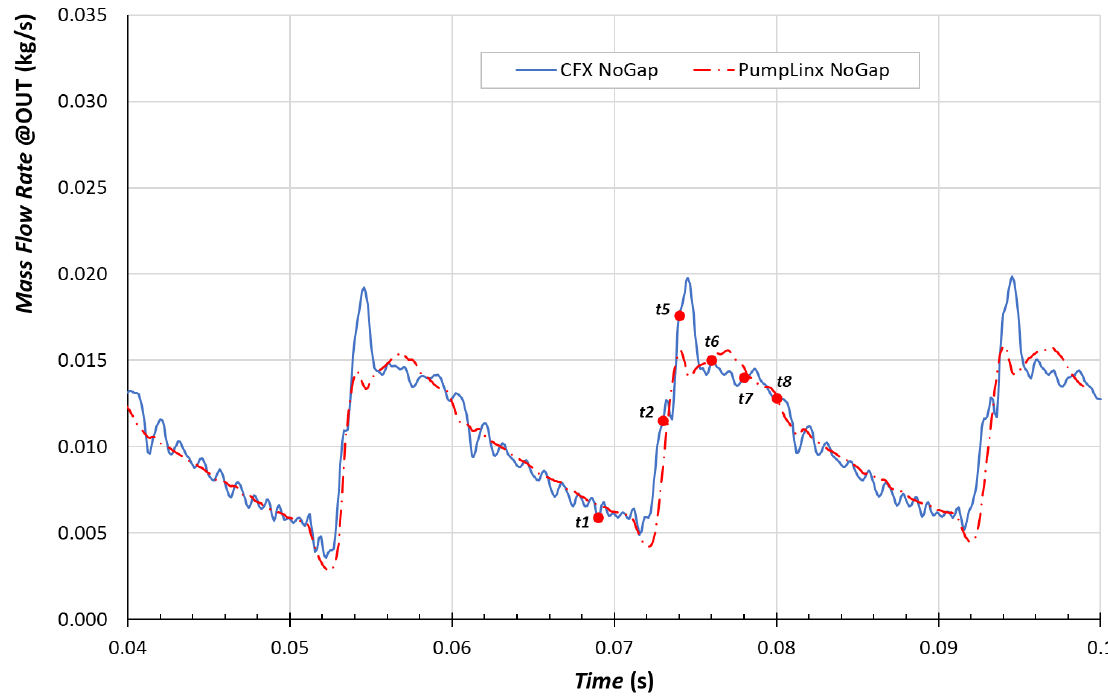
Figure 12. Instantaneous mass flow rate at the outlet port during the last three orbit revolutions of the rotating scroll: CFX (solid line) vs. Pumplinx (dash-dot line).